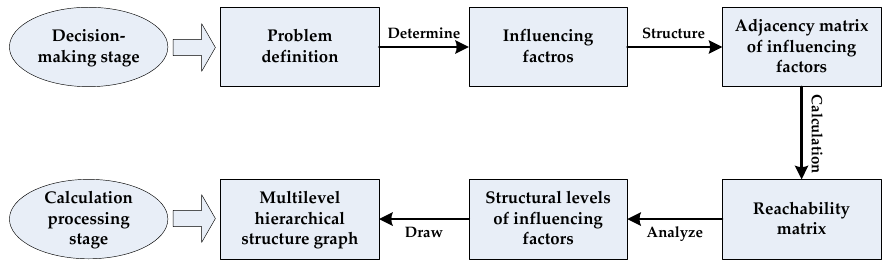
Figure 2 The workflow of the ISM method. Figure 2. The workflow of the ISM